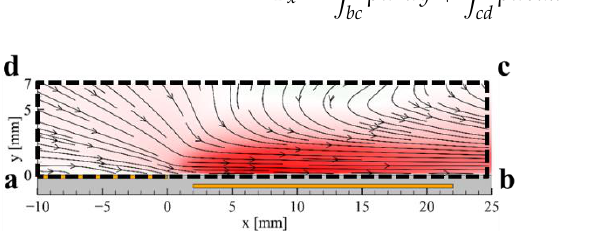
Figure 20. Control volume for the momentum conservation equation.